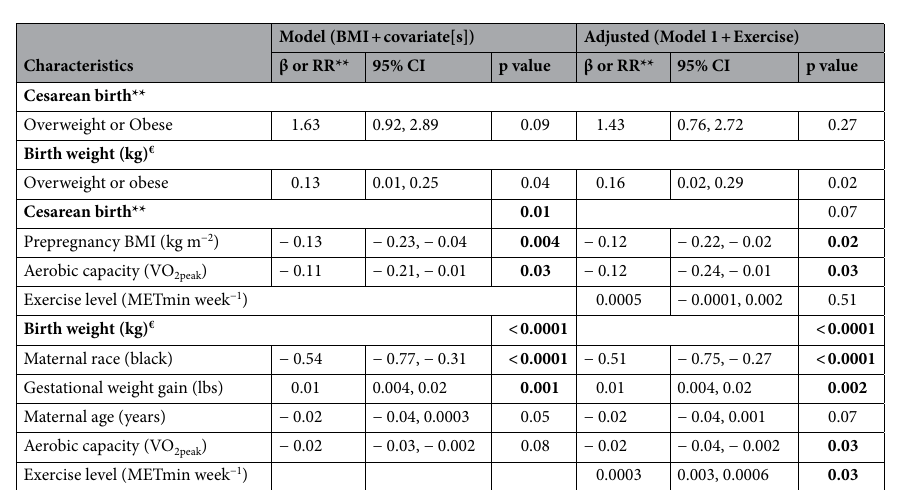
Table 4. Linear and Poisson regression coefficients (β, 95% CI, p value) for the effects of prenatal exercise on overweight or obesity on cesarean birth and birth weight. *Model-specific covariates included (1) cesarean birth: maternal race, MET∙min∙week −1 ; (2) birth weight: gestational age, maternal race, MET∙min∙week −1 . **Poisson regression was performed, and the respective relative risks and 95% CIs were reported. € Linear regression was performed and the respective βs and 95% Cis were reported. Normal weight served as referent group. Significant values are in [bold].